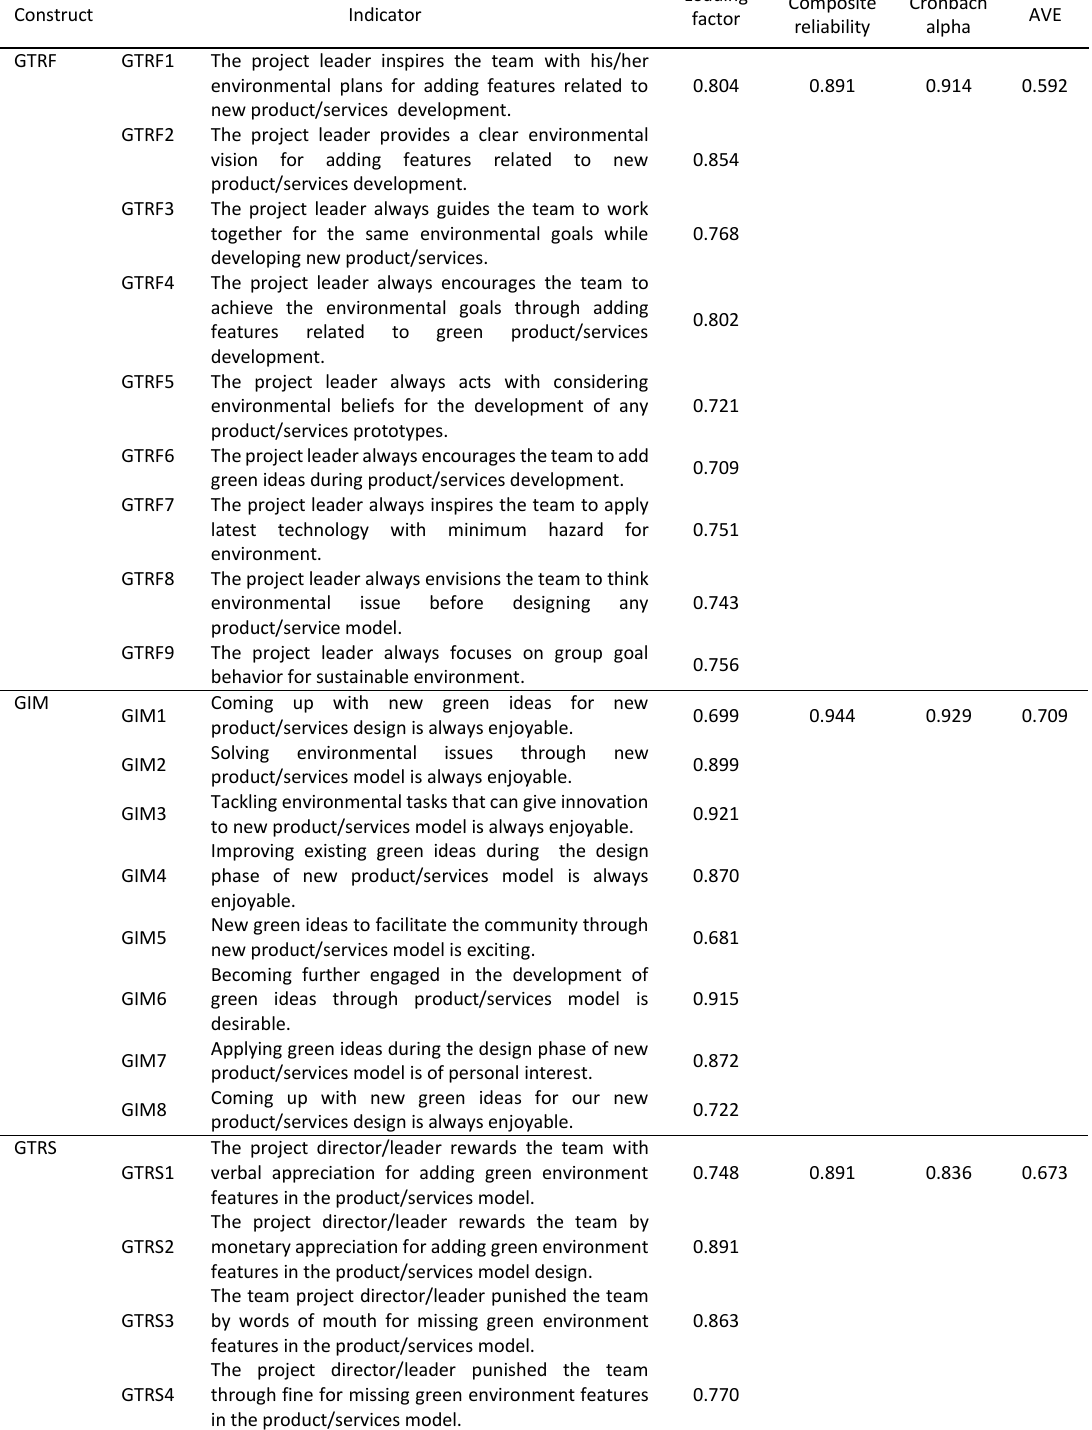
Table 2: Assessment result of measurement model